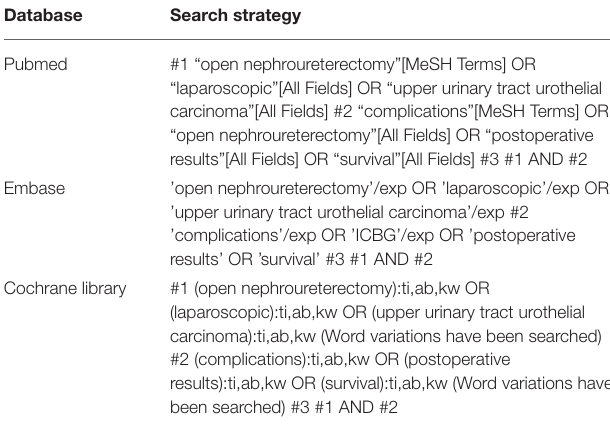
TABLE 1 | Search strategy for each